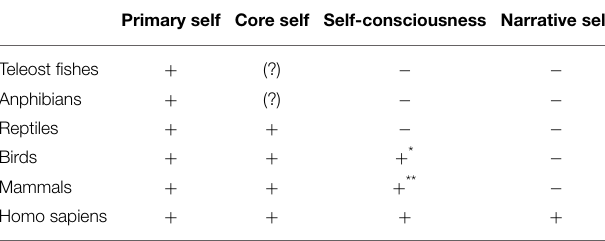
TABLE 1 | Representation of the self in the main classes of